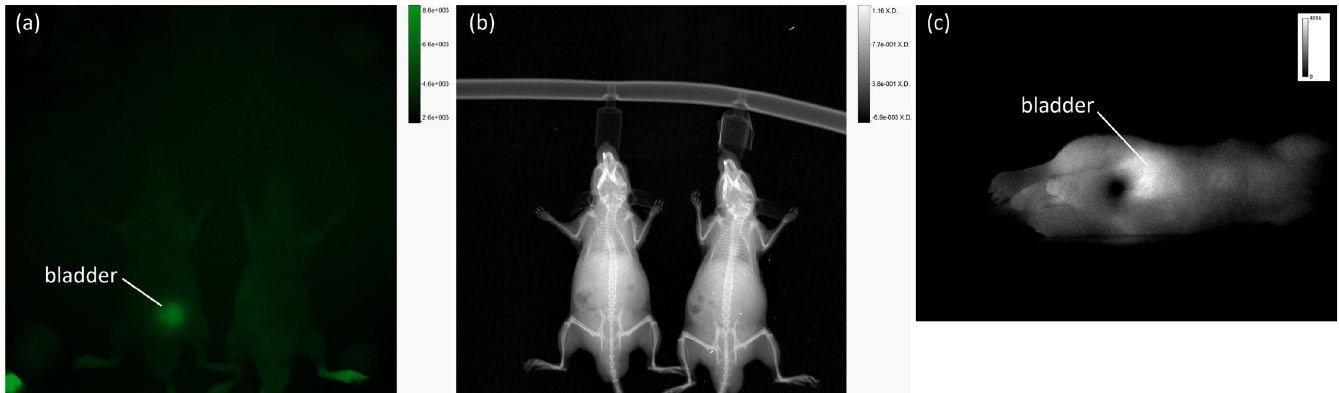
Fig 5. Depiction of the results of the pilot measurements. (Fig 5A) Fluorescence and (Fig 5B) X-ray imaging at 1 h p.i. using AuNP-SIDAG-BBN in healthy mice with the In-Vivo Xtreme system with an exposure time of 60 s. (Fig 5C) Fluorescence imaging at 1 h p.i. using AuNP-SIDAG-BBN in healthy mice with the developed setup and an exposure time of 50